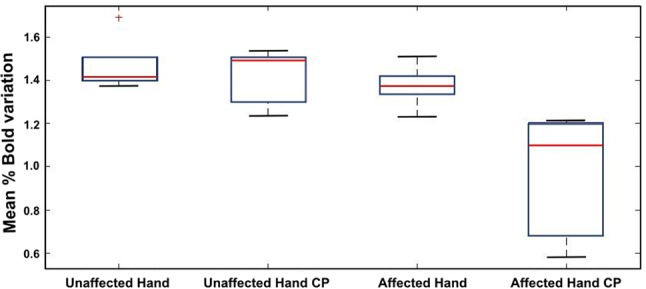
Comparative study of the mean amplitude of the BOLD response to the affected vs. unaffected hand motor task in the case of NCP and CP patients.